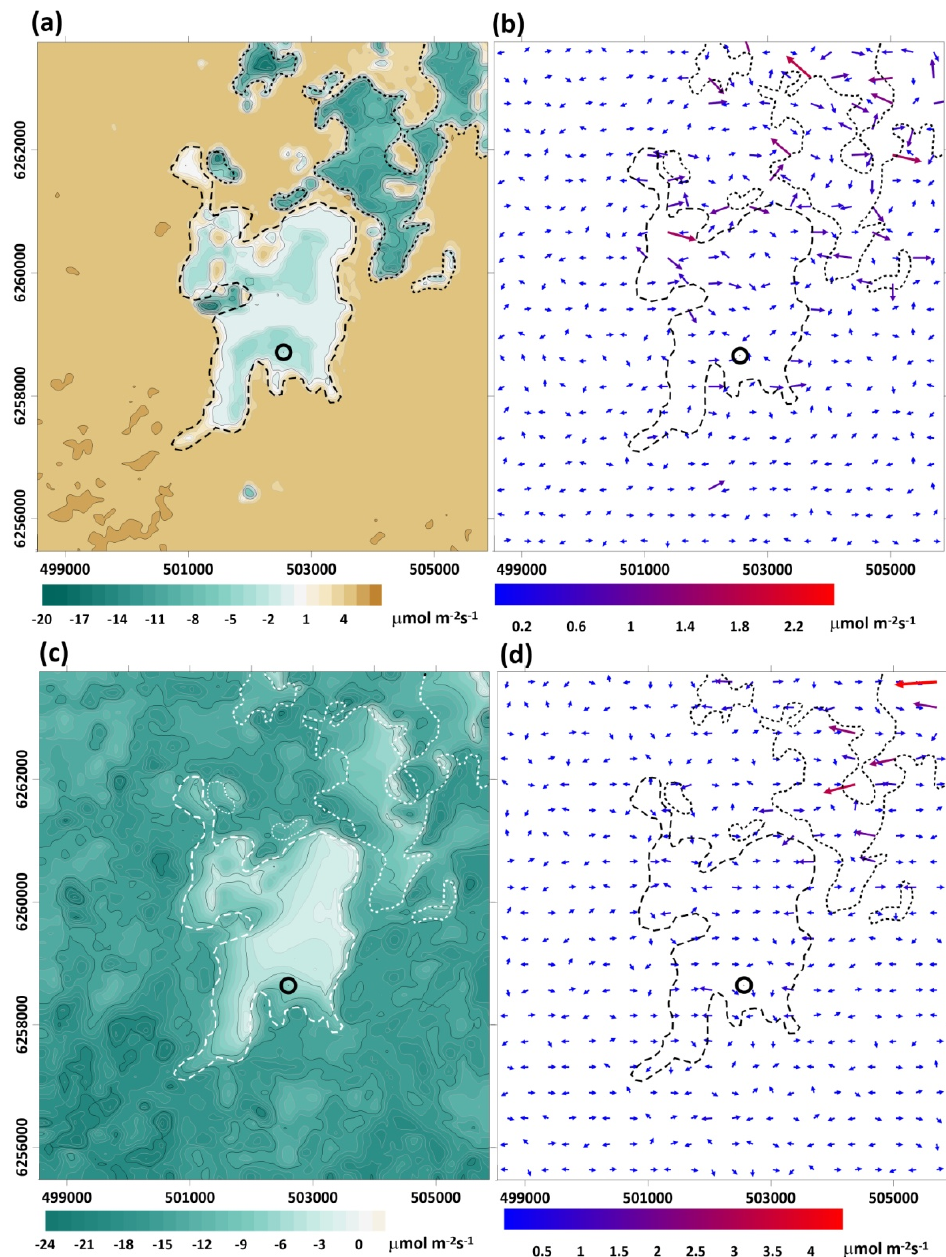
Figure 6. Modeled vertical ( a , c ) and horizontal ( b , d ) CO 2 fluxes (turbulent and advective) at the heights of 3 ( a , b ) and 30 ( c , d ) m above the ground. Calculations were performed using meteorological data at 14:00 on 25 June 2016. The medium-dashed line shows the peatland boundary. The short- dashed line shows the boundaries of abandoned lands with grassy vegetation and open places. The black circle indicates the location of the eddy covariance flux station. The coordinate system is Universal Transverse Mercator (UTM,